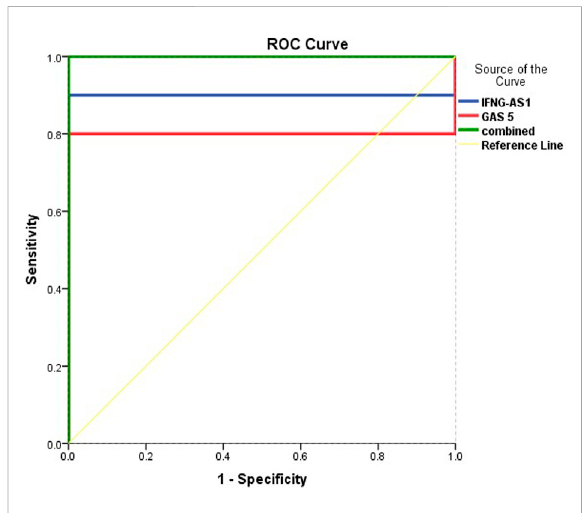
FIGURE 5 ROC curve analysis to predict diagnostic values of target genes in differentiating ITP patients from controls.